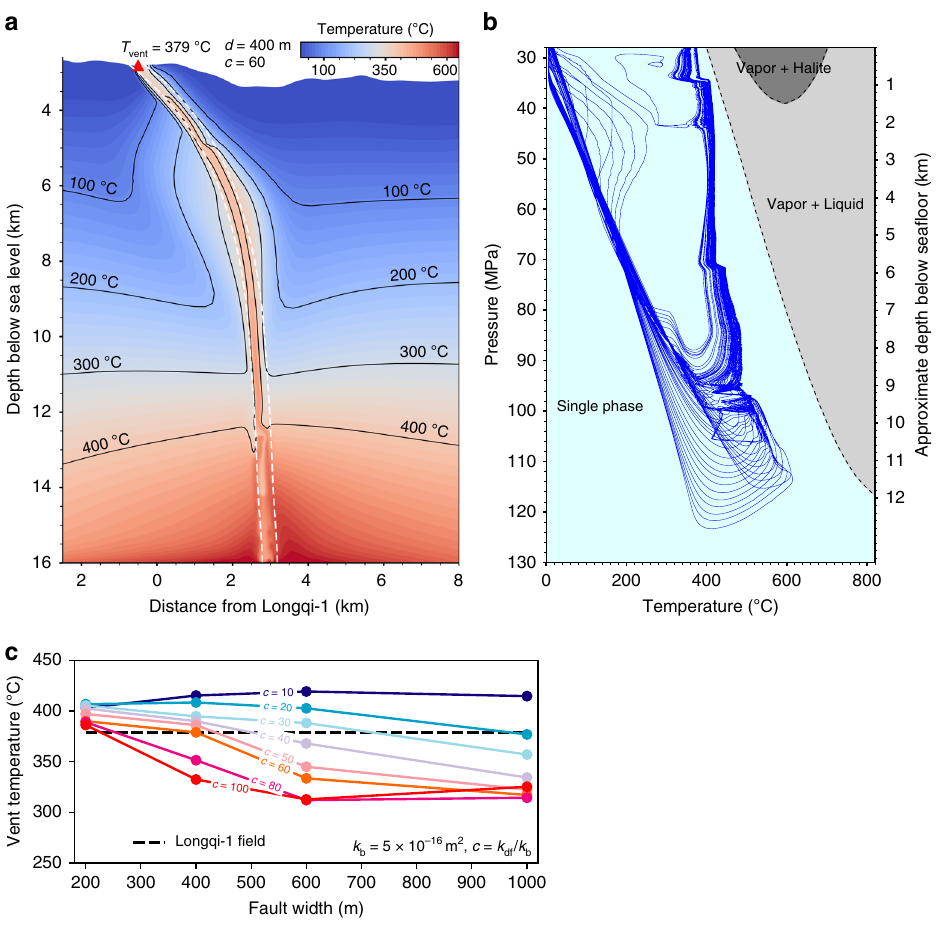
Fig. 3 2D numerical model of hydrothermal circulation. a An example hydrothermal modeling with constant fault width and the permeability contrast between fault and background. In this case, the assumed fault width ( d ) is 400 m, and the permeability contrast ( c = k df / k b ) is 60 ( k df = 3 × 10 − 14 m 2 , k b = 5 × 10 − 16 m 2 ). Temperature fi eld distribution is at quasi-steady state, and the isotherms for 100, 200, 300, and 400 °C are shown in green and the simulated vent fi eld with high temperature of 379 °C is shown by red triangle. b The temperature – pressure paths of fl uid tracers in our 2D numerical model. The blue lines are the modeled possible circulation paths for the hydrothermal circulations. Dashed lines mark phase regions ( fi lled in different colors) of seawater. c The comparison of the assumed fault width with the predicted venting temperature. c = k df / k b = 10 – 100, and the horizontal dashed line represent the observed highest temperature of Longqi-1 venting fl uids.